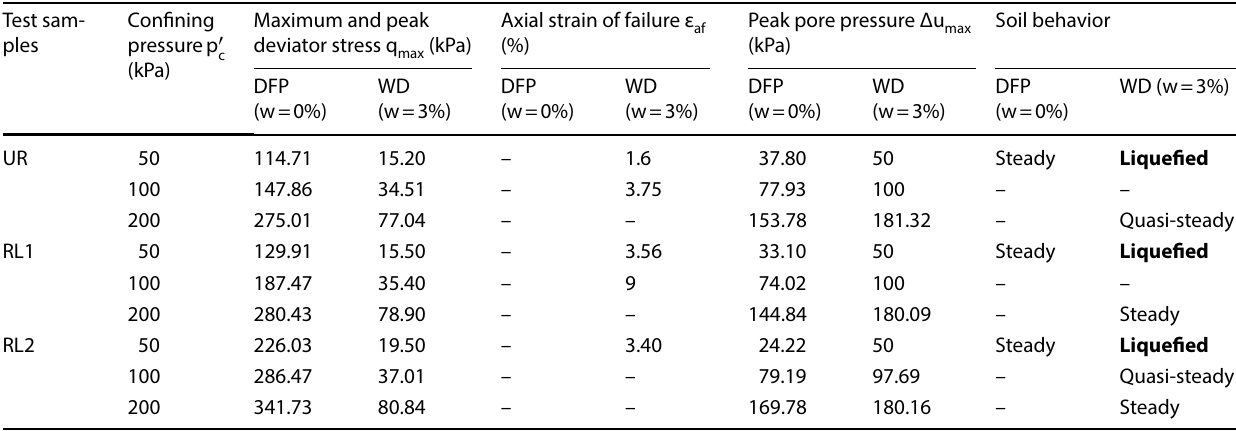
Bold indicates the text is used in order to indicate the state of soil